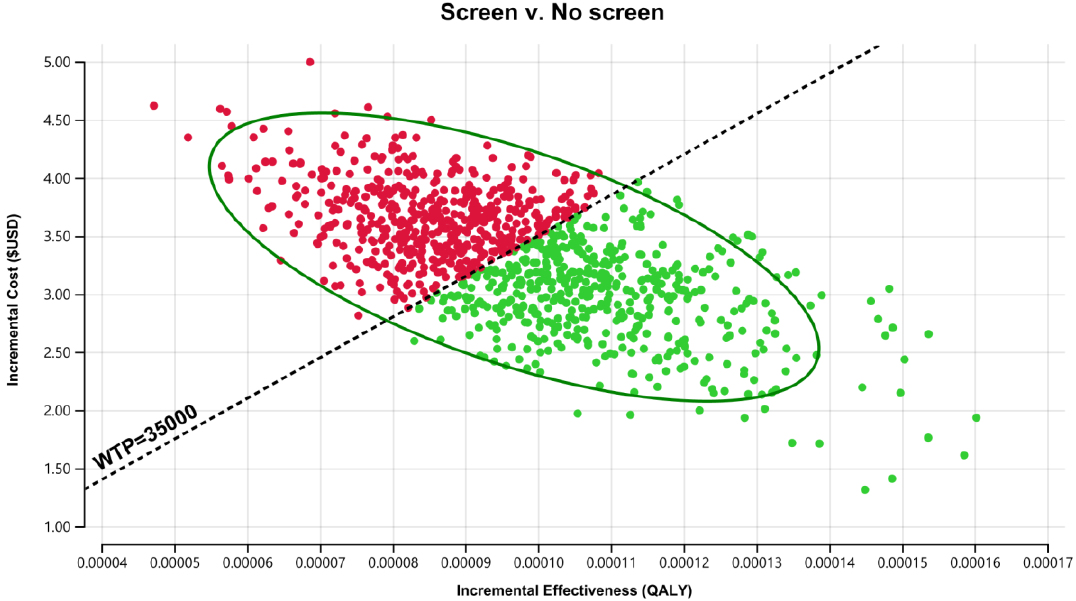
Figure 4. Cost-effectiveness plane for SCID NBS vs. no NBS, government perspective over 60 years, discounted US$ (d = 3% p.a.). (Note: Green dots represent iterations considered cost-effective (ICER less than the willingness-to-pay (WTP) threshold US$35,000/QALY); while red dots represent iterations considered not to be cost-effective (ICER greater than the WTP threshold).